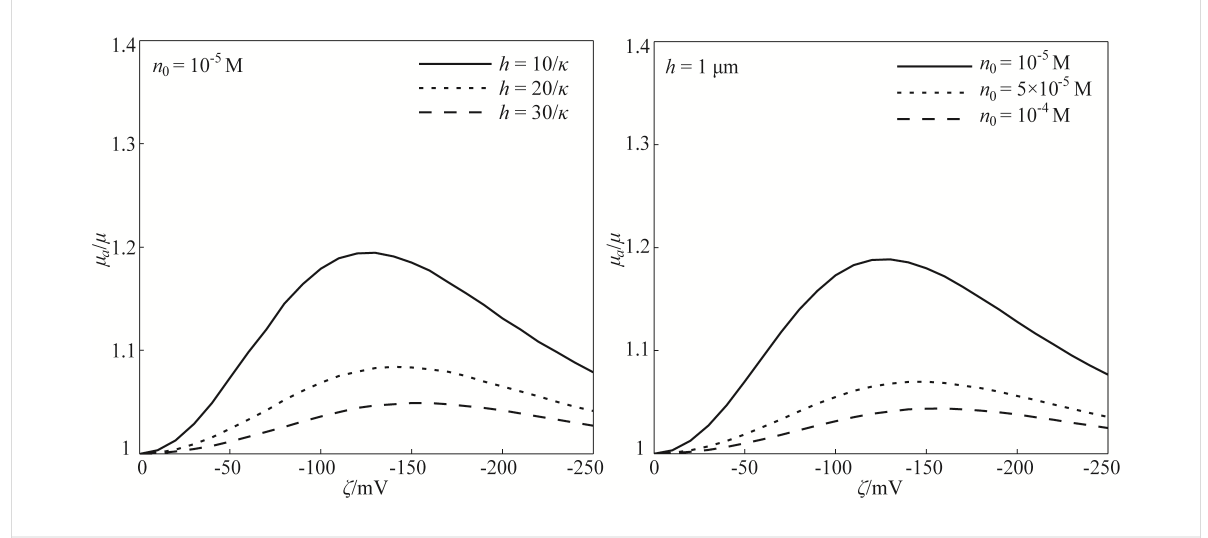
Figure 4: The effect of the zeta potential on the apparent viscosity of the lubricant and the dependence of the EDL-induced apparent viscosity on the lubricant film thickness and ion concentration of the lubricant based on the model of nonlinear PBE and modified electrical conductivity.